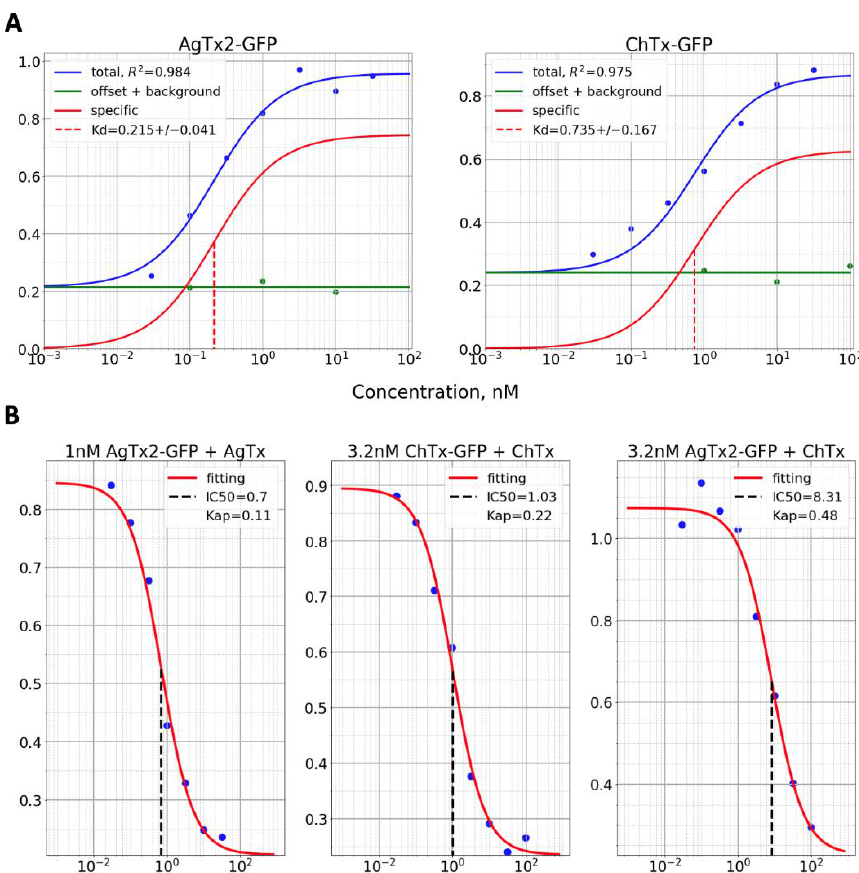
Figure 4. Analysis of ligand binding curves for direct ( A ) and displacement ( B ) titrations. ( A ) Experimental data points and fitted binding curves for AgTx2-GFP ( left ) and ChTx-GFP ( right ) are presented in blue. Nonspecific binding data and curves are presented in green. Binding curves with subtracted nonspecific binding are shown in red. Values for R 2 and calculated K d s are indicated on the graphs. Concentrations corresponding to K d are also shown as vertical dashed lines. ( B ) Displacement of 1 nM AgTx2-GFP (first graph), 3.2 nM ChTx-GFP (second graph) or 3.2 nM AgTx2 (third graph) with unlabeled AgTx2 (first graph) or ChTx (second and third graph). Experimental data points and fitted curves are depicted. The concentration of unlabeled toxins that displace 50% of the labeled ligands are shown as vertical dashed lines and indicated by numbers. Derived K ap values are also presented.